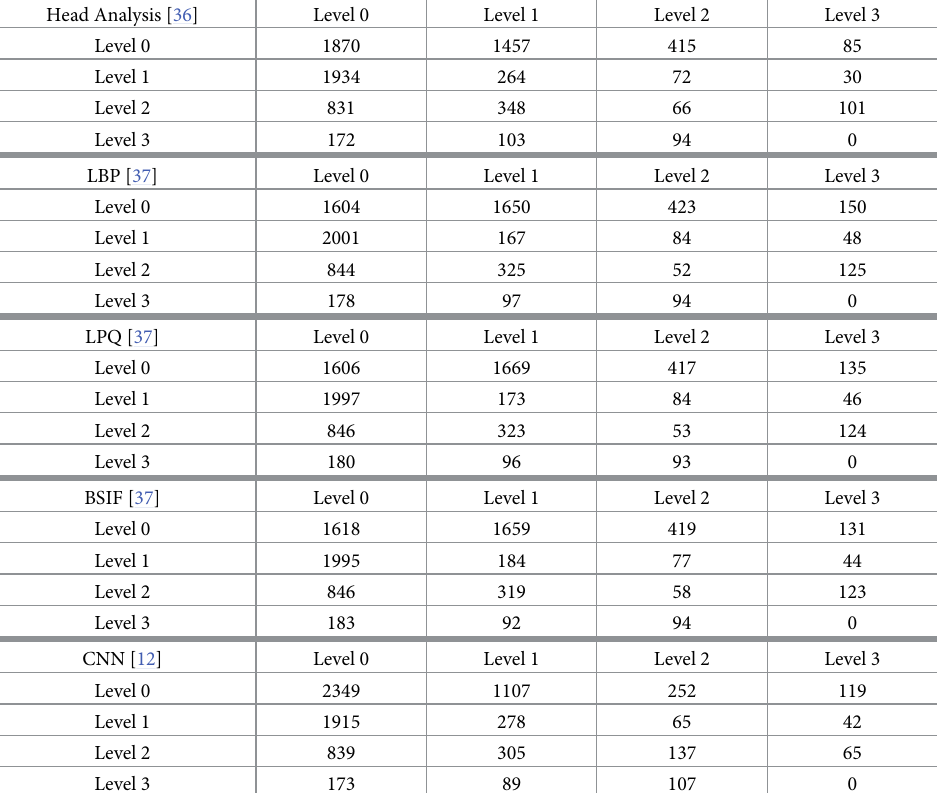
Table 7. Confusion matrixes of the state-of-the-art